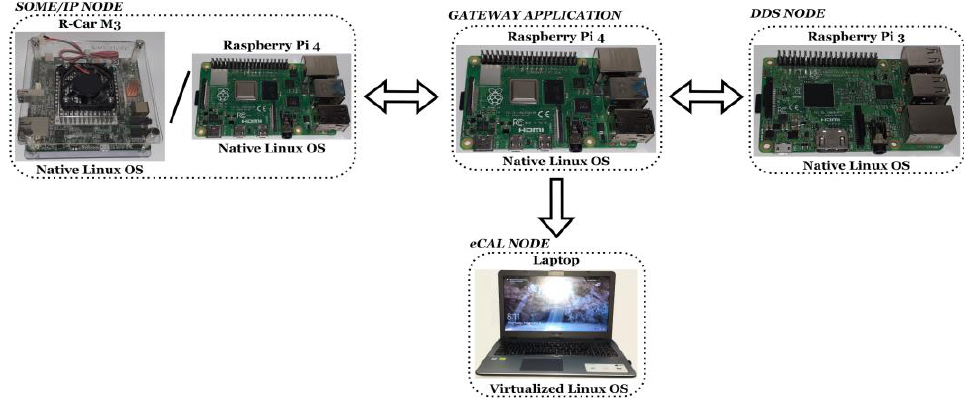
Figure 3. Hardware architecture.